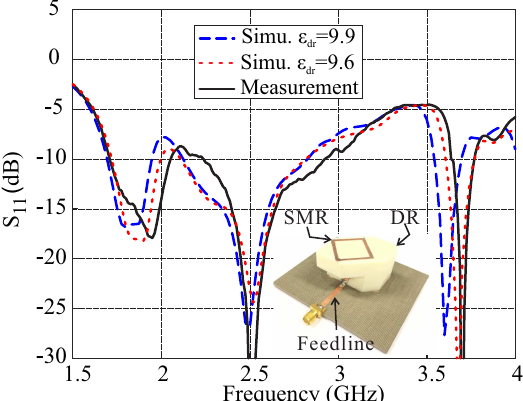
Figure 9. Simulated and measured reflection coefficients of the proposed antenna.